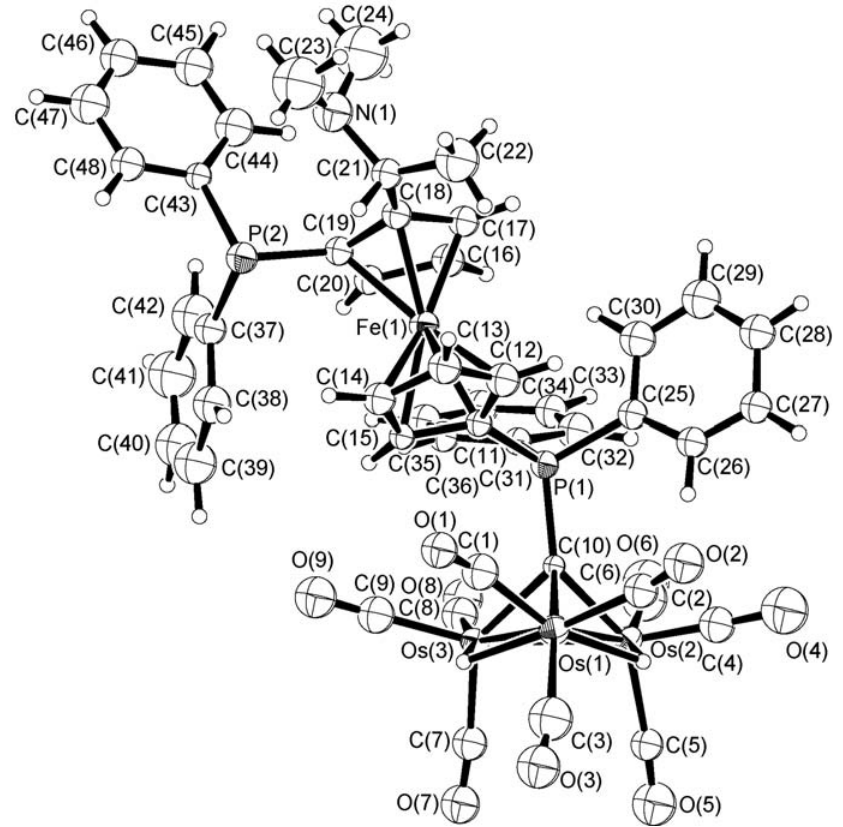
Figure 1. The molecular structure of 1 with atomic labeling and thermal ellipsoids are shown at the 30% probability level.